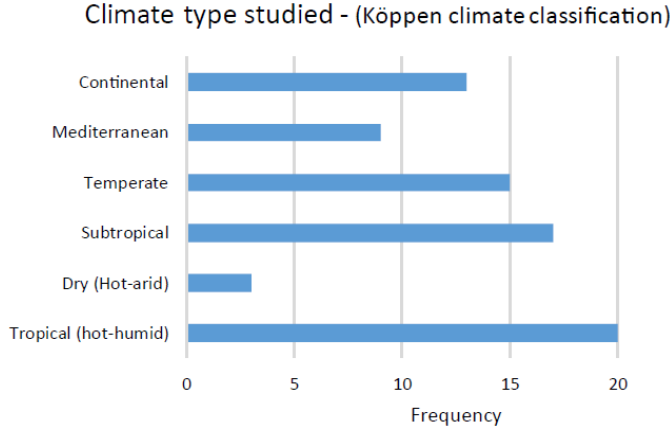
Figure 1. Distribution of studies according to climate type [40].